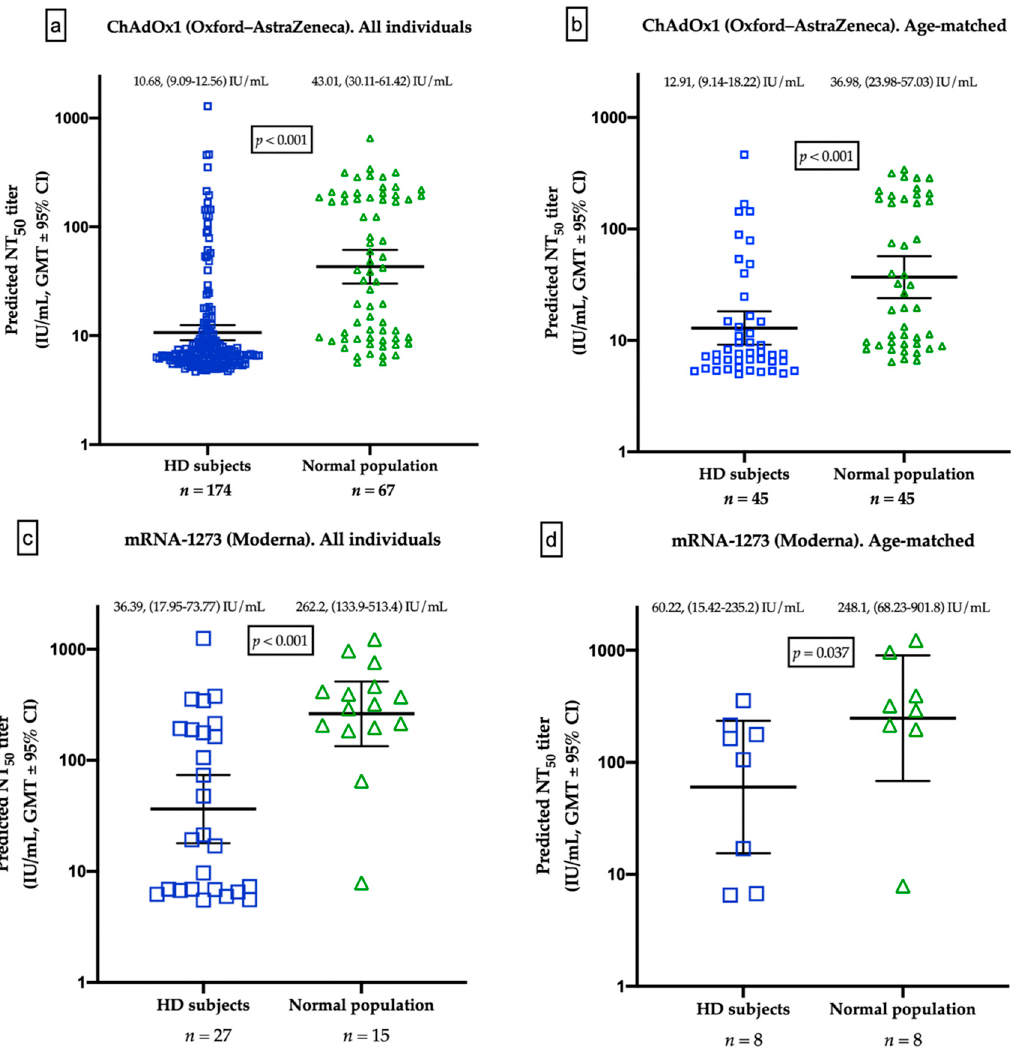
Figure 3. ( a ) Comparison of geometric mean titers (GMTs) for neutralizing antibodies (nAbs) between hemodialysis patients and healthy controls vaccinated with a first dose of ChAdOx1. ( b ) Comparison of GMTs for nAbs from age-matched hemodialysis patients and healthy controls vaccinated with a first dose of ChAdOx1. ( c ) Comparison of geometric mean titers (GMTs) for nAbs from hemodialysis patients and healthy controls vaccinated with a first dose of mRNA-1273. ( d ) Comparison of GMTs for nAbs from age-matched hemodialysis patients and healthy controls vaccinated with a first dose of